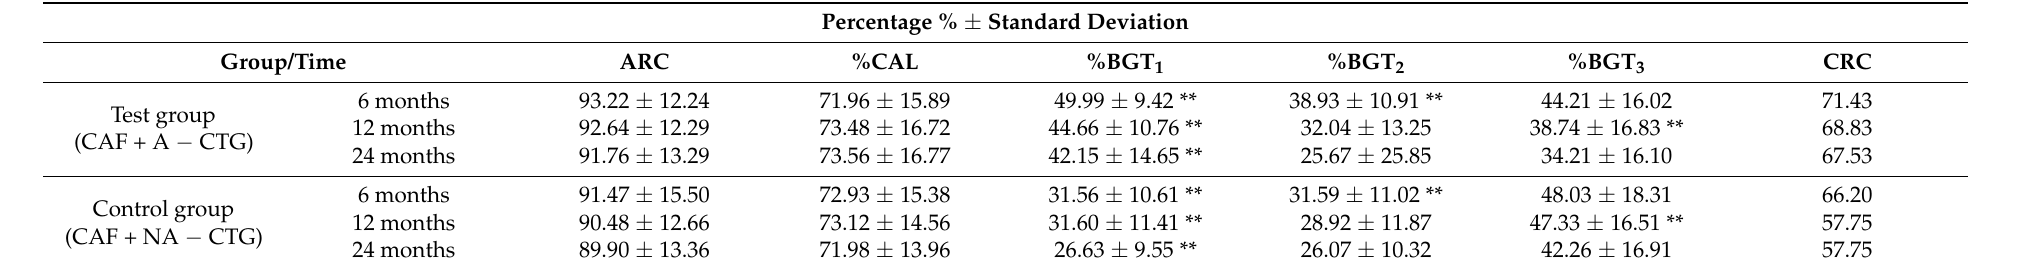
Table 3. Descriptive statistics recorded between 6, 12 and 24 months